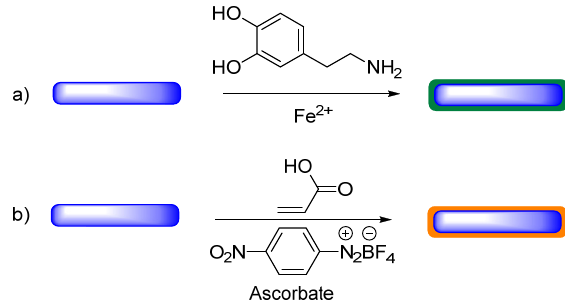
Figure 1. ( a ) An approach for polymer growth on silk membranes using polydopamine [28]; ( b ) the approach presented herein.